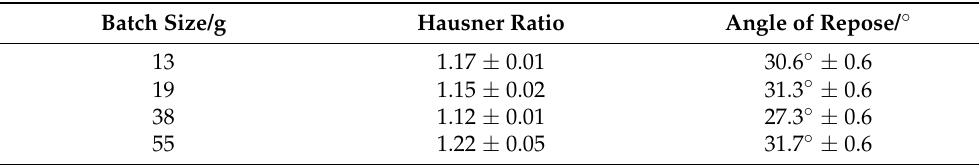
Figure 12. Microscopic images of QESD MF agglomerates after 50 mL (( left ), average SF: 1.60%) and 150 mL (( right ), average SF: 3.37%) of MF solution crystallized. Table 1. Influence of batch size during MSMPR crystallization on the flowability of the QESD MF agglomerates (mean ± s, n =